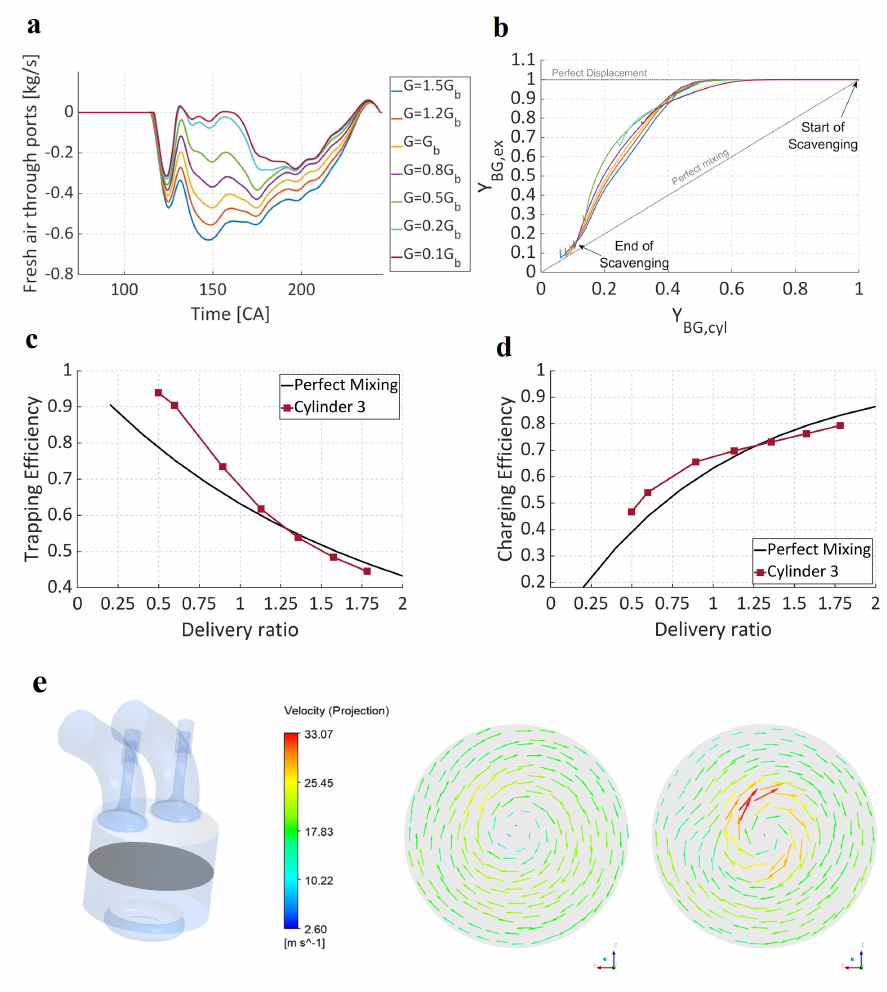
Figure 12. Scavenging performance for Cylinder 3. ( a ) Computed flow rate of Fresh Air through intake ports for different inlet mass flow rates as a function of CAD. ( b ) Burned gas mass fraction profiles. ( c , d ) Comparison between the computed trapping ( c ) and charging ( d ) efficiencies and the perfect mixing theoretical profiles vs delivery ratio. ( e ) Velocity vectors colored with velocity magnitude in a cylinder cross-section for G in = 0.045 kg/s (left) and 0.2249 kg/s